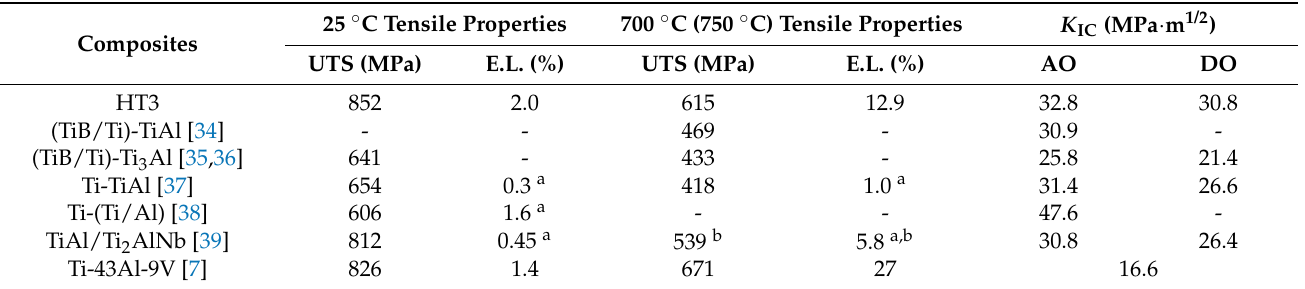
a Data obtained from the figure. b Properties tested at 750 ◦